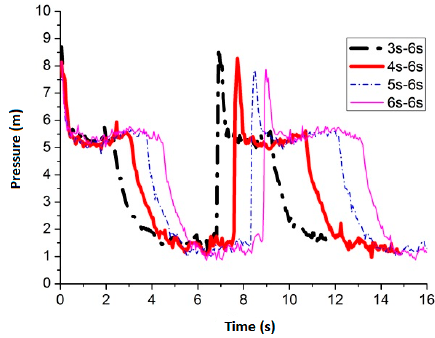
Figure 19. The four best pressure values (rectangular nozzle at the bottom of the pipe).